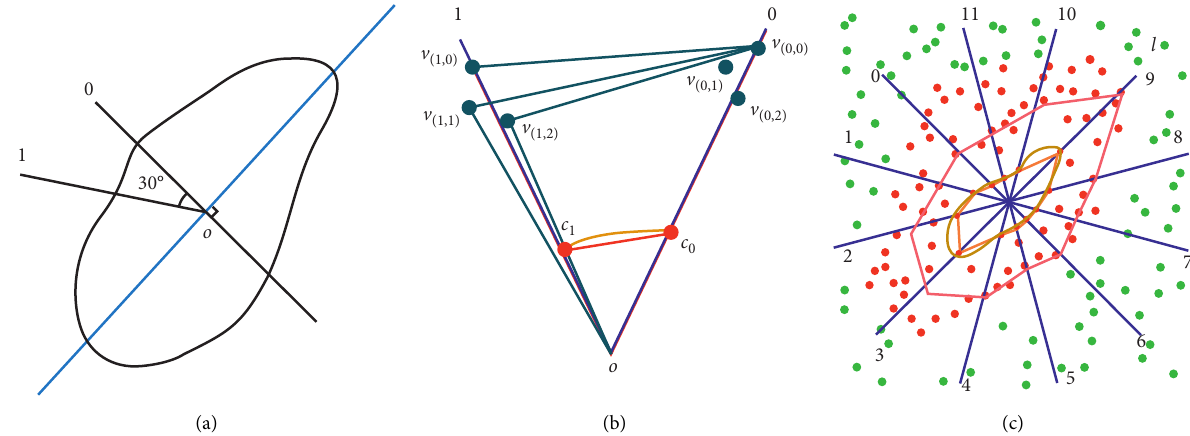
Figure 6: Feature representation approach based on the axis of least inertia. (a) The axis of least inertia is used as the reference axis. (b) Characteristic triangle. (c) The brownish yellow color is the lumen contour, the orange color is the lumen contour feature triangle, and the red color is one of the candidate contours obtained based on the